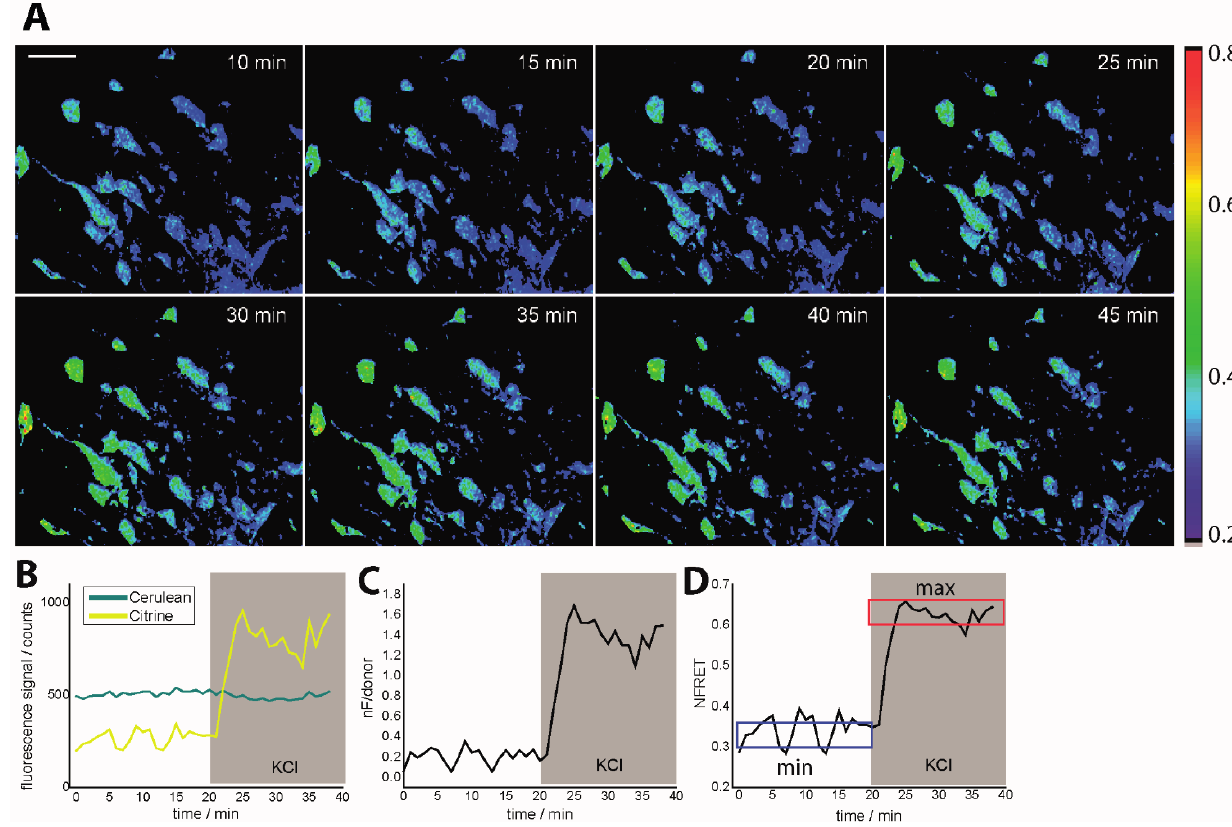
Figure 1. Intravital ratiometric FRET in healthy CerTN L15 mice. ( A ) Time-lapse of NFRET ratio of a 300 × 300 × 70 µm 3 region in the brain stem of a CerTN L15 mouse before and during KCl treatment; ( B ) Cerulean and Citrine (donor and acceptor in TN L15 ) corrected averaged fluorescence signals during KCl treatment as well as averaged nF /donor ratio ( C ) and averaged NFRET ratio ( D ) time-evolutions. In ( D ), the blue frame defines the minimum NFRET ratio in healthy neurons, while the red frame defines the maximum NFRET ratio as given by treatment with KCl. The maximum NFRET ratio was validated by treatment with glutamate but is not the maximum reachable NFRET ratio as predicted by neurophysiology. The tolerance range for both minimum and maximum NFRET values is ≈ 0.1. CerTN L15 mice are genetically encoding the FRET-based Ca 2+ -biosensor TN L15 in neurons. λ exc = 850 nm, λ em (Cerulean) = 475 ± 20 nm, λ em (Citrine) = 535 ± 25 nm. Scale bar = 50 µm. All images are represented as xyz